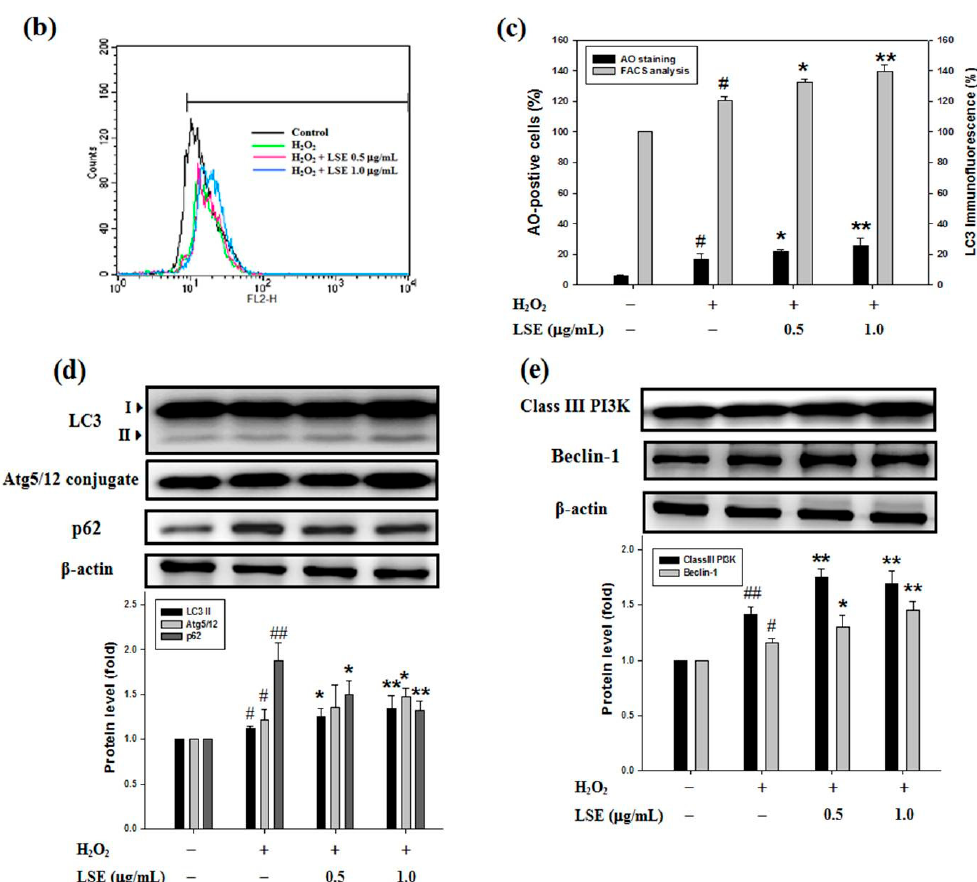
Figure 4. Effect of LSE on H 2 O 2 -mediated autophagy in beta-cells. RIN-m5F cells were treated with or without the indicated doses of LSE (0.5 and 1.0 µ g / mL) in the presence of 200 µ M of H 2 O 2 for 24 h. ( a ) Autophagy was analyzed by the acridine orange (AO) stain method. Arrows indicate autophagic cells. Panels represent (from upper to lower ) phase-contrast microscopy ( upper ), AO staining ( middle ), and merge image ( lower ). Images were taken at 200 × magnification; scale bar, 30 µ m. ( b ) The immunofluorescence intensity of LC3 was carried out by flow cytometry. ( c ) The percentage of AO-positive cells relative to the total cell number ( left axis ) in each random field ( > 100 cells) and the immunofluorescence intensity of LC3 ( right axis ) are, respectively, shown as mean ± SD ( n ≥ 3) from three independent experiments. ( d – e ) For the analysis of autophagic factors, the protein levels of LC3 (microtubule-associated protein light chain 3) I / II, Atg (autophagy-related genes) 5 / 12 conjugate, p62 ( d ), class III PI3K (phosphatidylinositol-3 kinase), and Beclin-1 ( e ) were assayed by Western blot analysis. β -actin served as an internal control. The quantitative results are presented as the mean ± SD ( n ≥ 3) from three independent experiments. # p < 0.05, ## p < 0.01, compared with untreated control; * p < 0.05, ** p < 0.01, compared with the H 2 O 2 group.